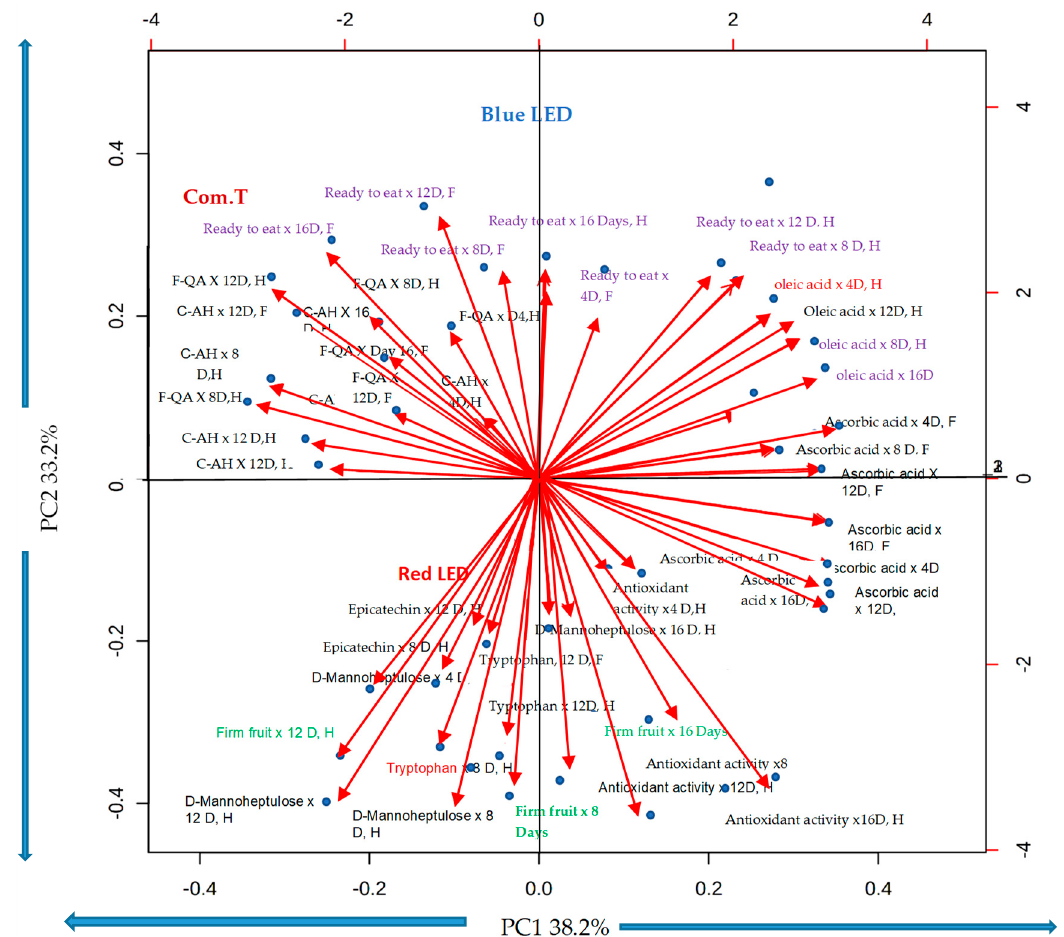
Figure 12. Principal component analysis (PCA) showing correlation loadings of fruit phenolic compounds; epicatechin in the pericarp; tryptophan, D-mannoheptulose sugar, ascorbic acid, oleic acid, and antioxidant activity in the mesocarp; and fruit ripeness related to the LED light treatments in comparison to the commercial treatment. F-QA, 3-feruloyl quinic acid; C-AH, coumaric acid hexoside; D, days; H, cv. Hass; F, Cv. Fuerte.